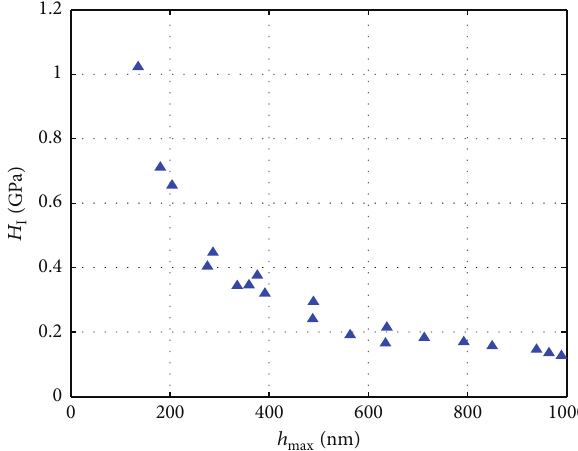
Figure 21: Indentation hardness of PS with molecular weights ( 𝑀 p ) of 52220 according to Oliver and Pharr method [53] obtained by a Berkovich tip with 1.2 𝜇 m/min loading and unloading rates and zero holding time [58].